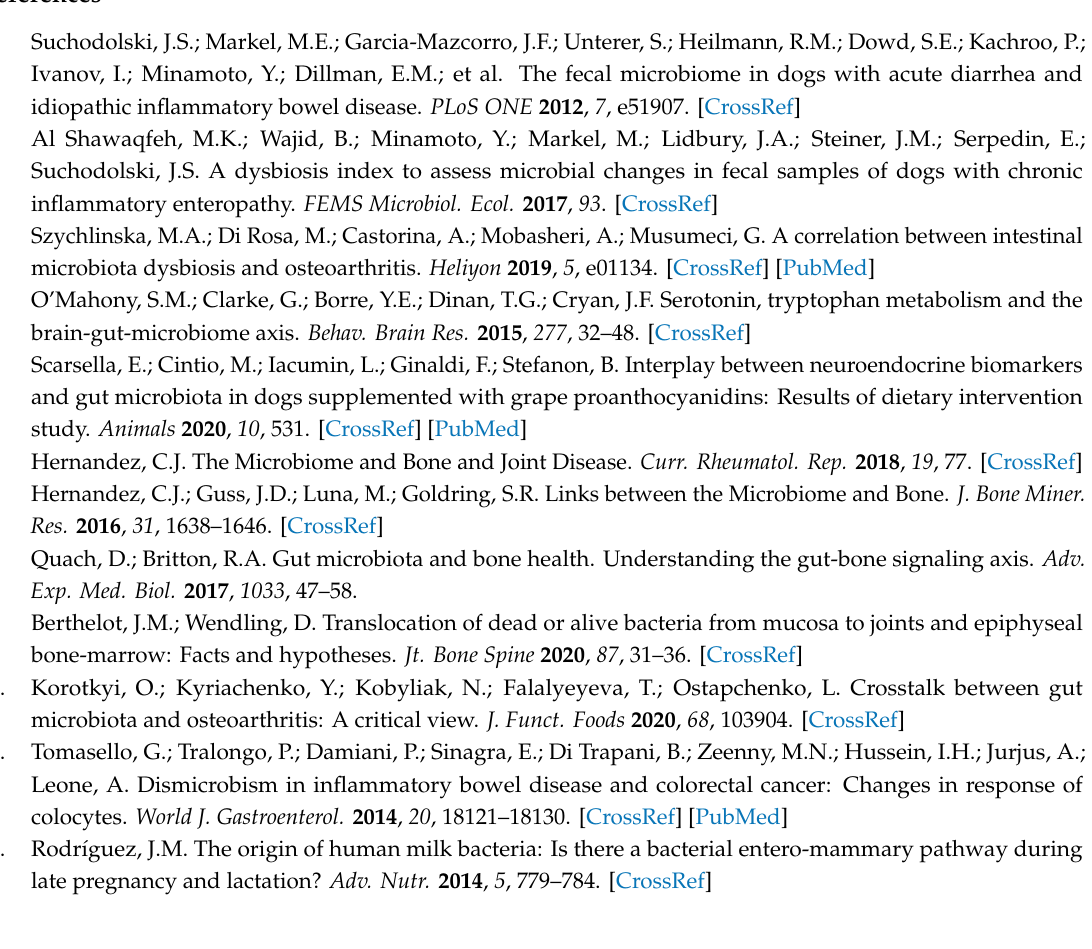
Table S1: Health status, kind of breed, sex, weight, and age of the dogs recruited for the study; Table S2: Mean concentrations ( µ mol / g) and molar proportions (%) of lactate and short-chain fatty acids in the feces of the dogs sampled at the beginning of the study (T0) and after 45 (T45) days; Table S3: Relative abundances of the prevalent families detected in dog feces samples at the beginning of the study (T0) and the end (T45); Table S4: Relative abundances of the prevalent genera detected in dog feces samples at the beginning of the study (T0) and the end